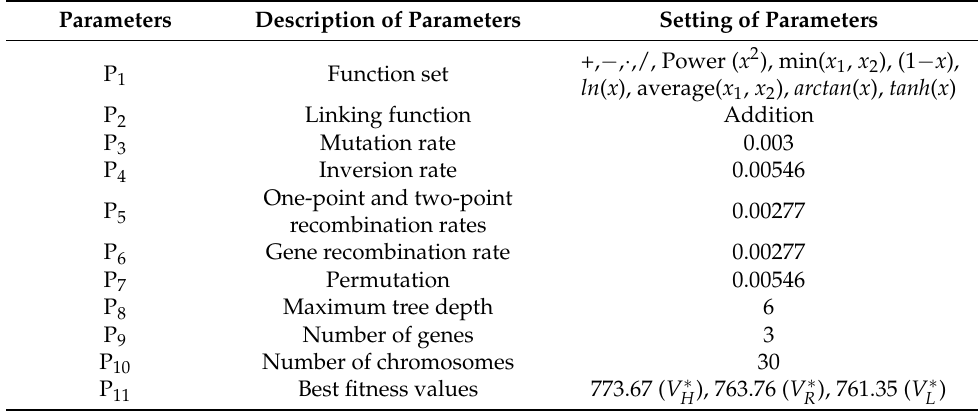
Table A2. Parameters of the GEP model for 3D-scour rate